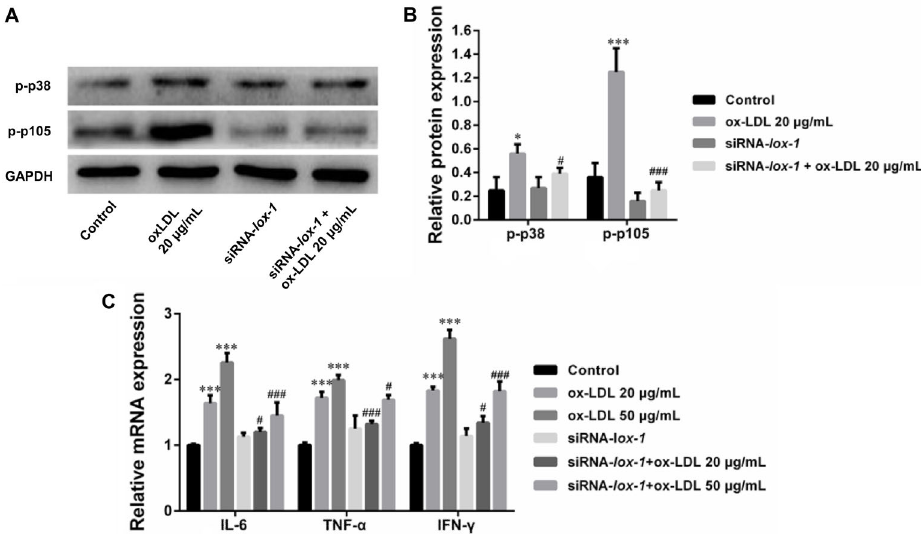
Figure 4. Inhibition of LOX-1 attenuated MAPK/NF- k B pathways and in fl ammatory cytokines. A and B , Expression of p-p38 and p-p105 in dendritic cells (DCs) after transfection with siRNA-LOX-1 and treatment by oxidized low-density lipoprotein (oxLDL). C , qRT-PCR analysis of pro-in fl ammatory cytokines in DCs after transfection with siRNA-LOX-1 and treatment by oxLDL. Data are reported as means ± SD (n=3). *P o 0.05, ***P o 0.01 vs control; # P o 0.05, ### P o 0.01 vs un-transfected groups